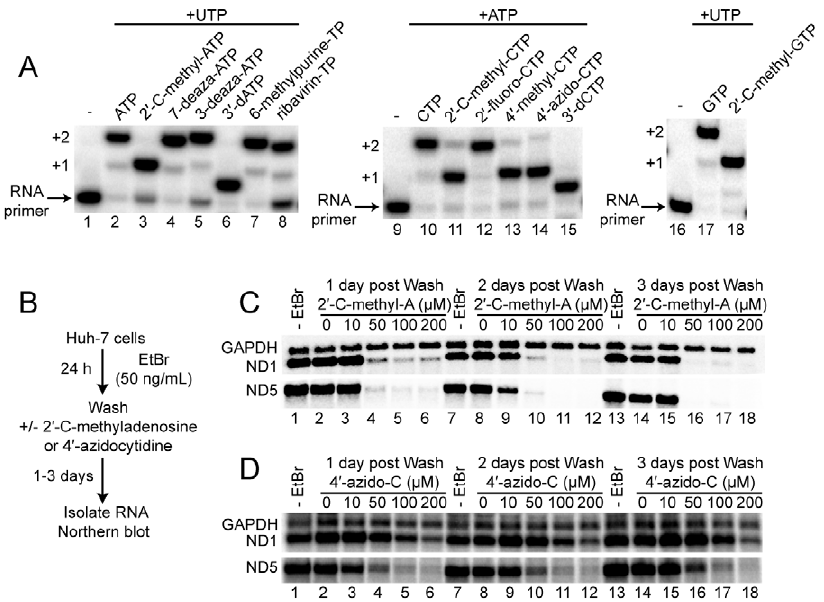
Figure 2. Non-obligate chain terminators inhibit RNA elongation by POLRMT. ( A ) Non-obligate chain termination of RNA synthesis in vitro. Products from POLRMT-catalyzed nucleotide incorporation in the presence of the next correct nucleotide substrate, UTP or ATP. Reactions proceeded for 10 min. Reactions containing ATP, 7-deaza-ATP, 3-deaza-ATP, 6-methylpurine-TP, ribavirin-TP, CTP,2 9 -deoxy-2 9 -fluoro-CTP and GTP were readily extended to n + 2 product by POLRMT. Reactions containing 2 9 -C-methyl-ATP, 2 9 -C-methyl-CTP, 4 9 -methyl-CTP, 4 9 -azido-CTP and 2 9 -C-methyl-GTP were unable to be extended to n + 2, demonstrating the ability of these nucleoside analogs to be non-obligate chain terminators for POLRMT once incorporated in nascent RNA. 3 9 -dATP and 3 9 -dCTP were used as positive controls. ( B–D ) Production of full-length mitochondrial RNA transcripts in cells is impaired in the presence of 2 9 -C-methyladenosine and 4 9 -azidocytidine. ( B ) Experimental design. Huh-7 cells were treated with EtBr for 24 h to deplete mitochondrial transcripts from cells, washed, treated with 2 9 -C-methyladenosine or 4 9 -azidocytidine for 1, 2 and 3 days, total RNA isolated and Northern blots performed. Northern blots of ND1, ND5 and GAPDH after EtBr treatment and recovery in the presence of ( C ) 2 9 -C- methyladenosine and ( D ) 4 9 -azidocytidine. Cells treated with a minimum of 50 m M 2 9 -C-methyladenosine showed specific inhibition of mitochondrial transcription and the inability to produce both ND1 and ND5 transcripts, whereas a minimum of 50 m M 4 9 -azidocytidine only inhibited production of ND5; GAPDH was unaffected by treatment with 50 m M 2 9 -C-methyladenosine or 4 9 -azidocytidine. At higher concentrations of 4 9 -azidocytidine GAPDH showed some sensitivity.